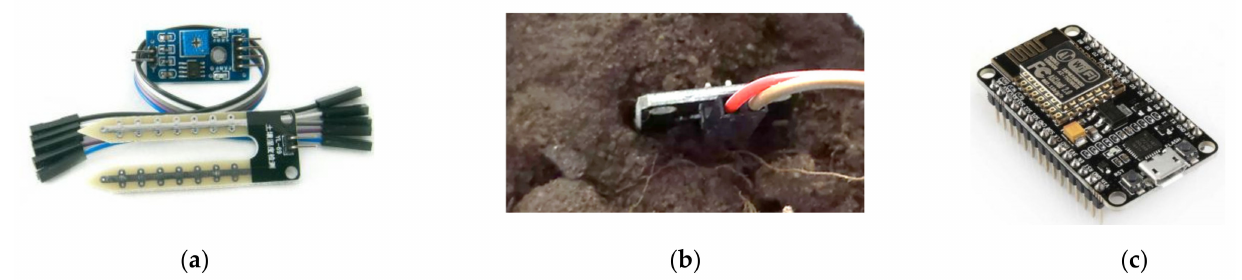
Figure 7. ( a , b ) Soil humidity sensor and; ( c ) NodeMCU